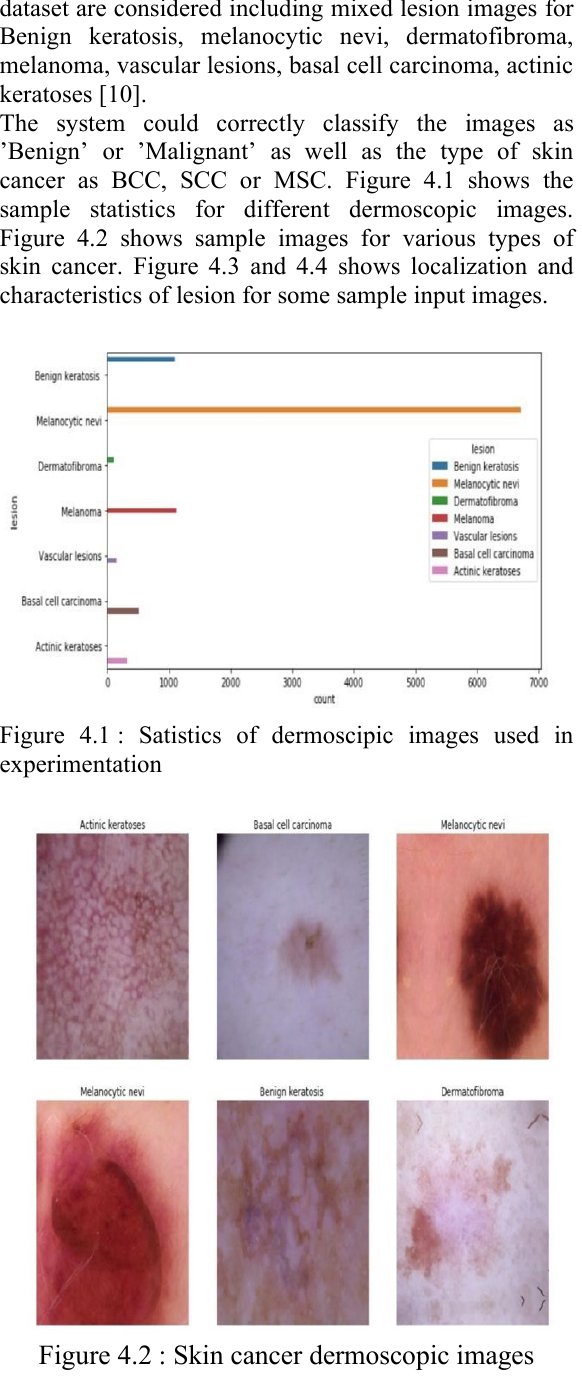
Figure 4.3: Localization of lesions